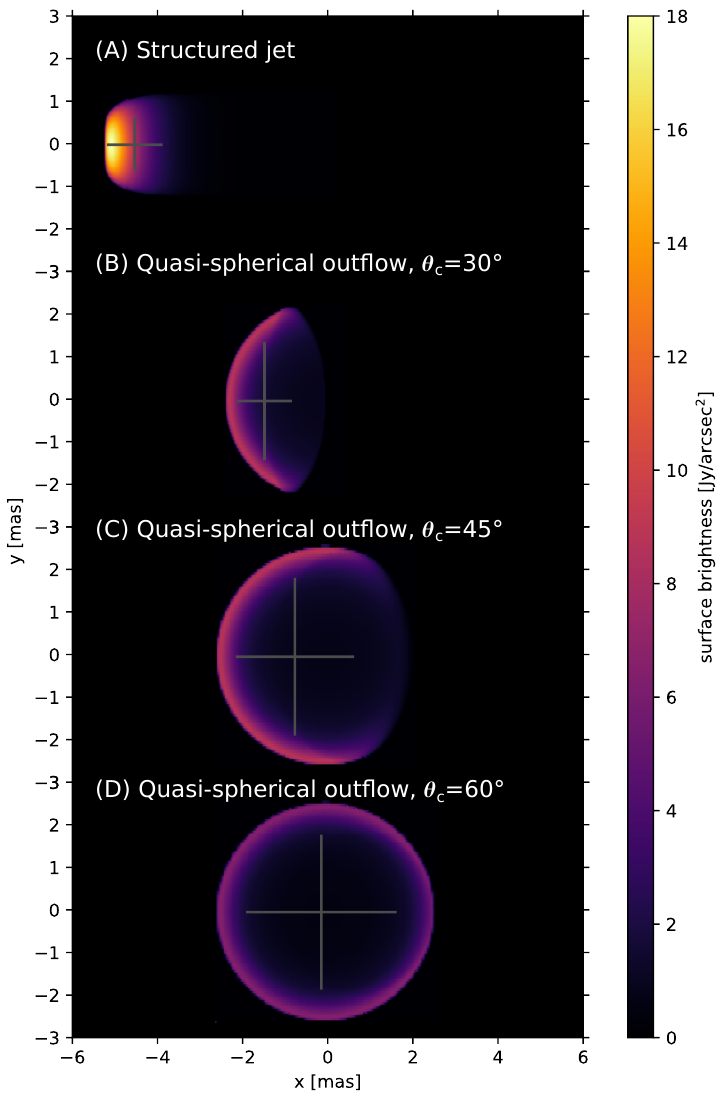
Figure 12. Model images of an off-axis structured jet (A) and of three quasi-spherical explosions (B, C and D) with similar parameters, but differing opening angles θ c . The angle between the line of sight and the shock symmetry axis in all cases is θ v = 15 ◦ . The images show the surface brightness at 5 GHz, 207 days after the merger, as seen from a distance of 41 Mpc. In each panel, the merger is located at coordinates ( 0,0 ) , while the grey cross shows the image centroid and the full width at half the maximum of the image in two perpendicular directions. All models are compatible with the observations of the GW170817 non-thermal multi-wavelength counterpart (shown in Figure 11) before the peak. Adapted from